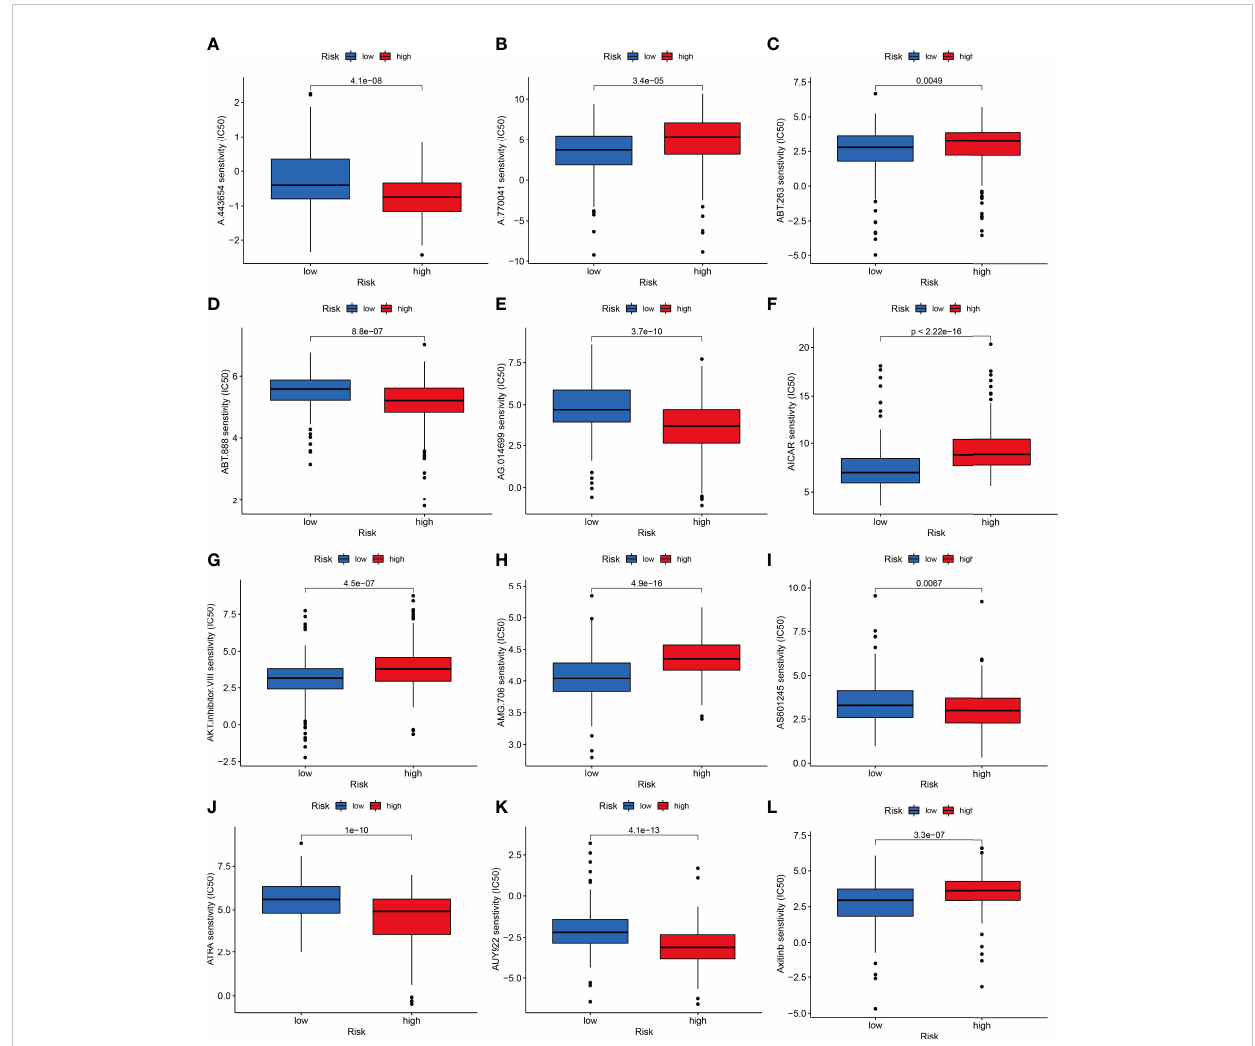
FIGURE 8 The low-risk group is shown in blue on the abscissa, and the high-risk group is shown in red. The IC50 value of drug target sensitivity is shown on the ordinate. (A) A.443654. (B) A.770041. (C) ABT.263. (D) ABT.888. (E) AG.014699. (F) AICAR. (G) AKT inhibitor VIII. (H) AMG.706. (I) AS601245. (J) ATRA. (K) AUY922. (L)